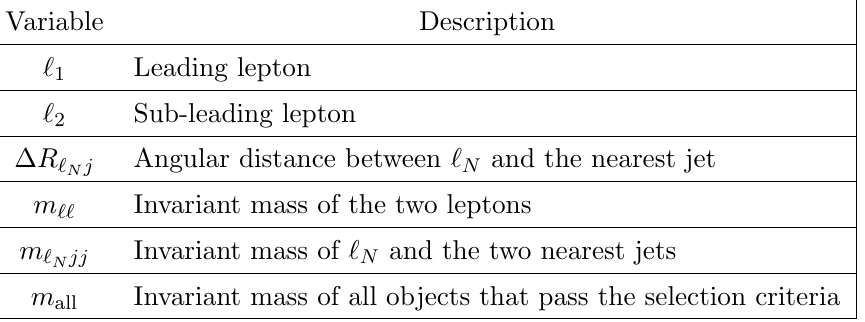
Table 3 . Description of the notation used in the two lepton analysis.